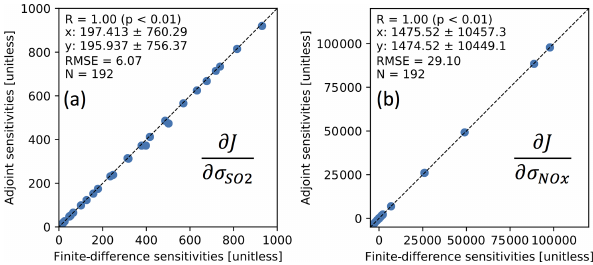
Figure 1. Validation of adjoint model sensitivity through compari- son to centered finite-difference results for a 3d simulation. Shown here is the sensitivity of the column cost function (penalty term is not included, and horizontal transport is turned off) with respect to the logarithm of anthropogenic SO 2 (a) and NO x (b) emission scale factors: the 1:1 line (dotted), number of grid columns ( N ), root mean squared error (RMSE), and correlation coefficient ( R ), and means and standard deviations of finite-difference sensitivity and adjoint sensitivity ( x and y